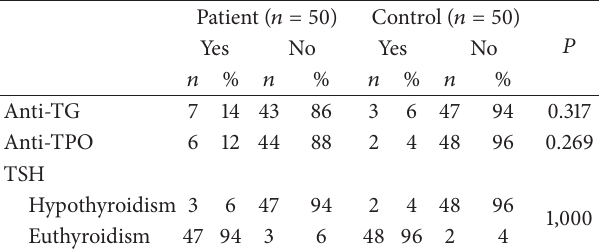
Table 1: The distribution of the patients and controls according to anti-TG antibodies, anti-TPO antibodies, and TSH